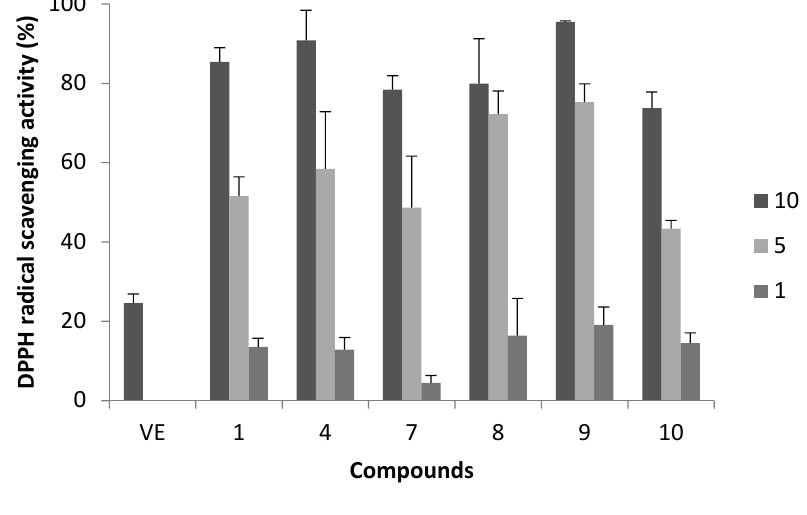
Figure 4. DPPH radical scavenging activity of synthesized compounds. 1 mL of 30 μ M of DPPH solution in EtOH was added to 1 μ L of sample solution in Dimethyl sulfoxide (DMSO) at final concentrations of 1, 5, and 10 μ M ( n = 6). Vitamin E was used as a control compound. Error bars represent standard deviation of the mean ( n =